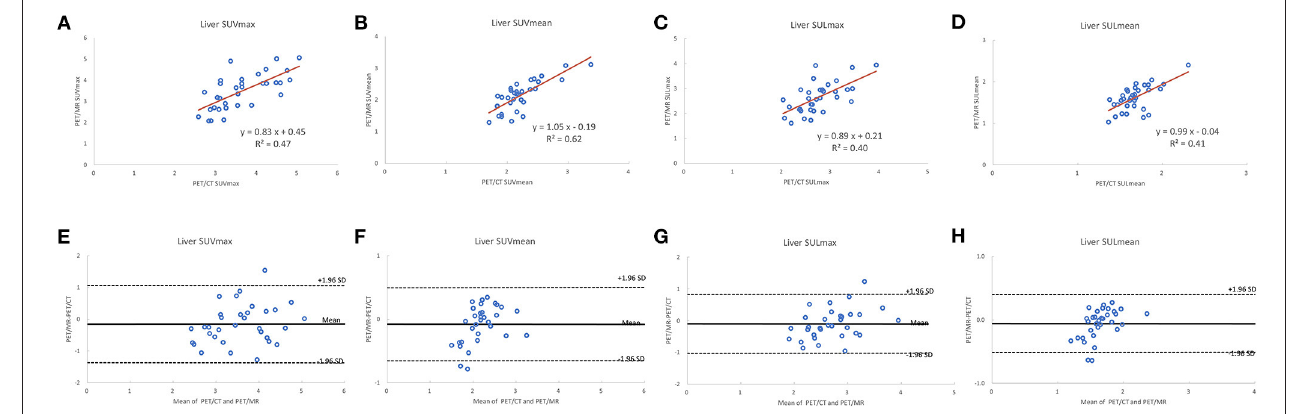
FIGURE 1 | Scatter diagram with regression line and Bland-Altman plots of PET-CT and PET-MR for SUVmax and SUVmean corrected to body weight (A,B,E,F) and lean body mass (C,D,G,H) .